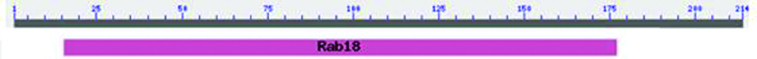
The putative Rab18 domain of the protein encoded by watermelon Rab18 gene.